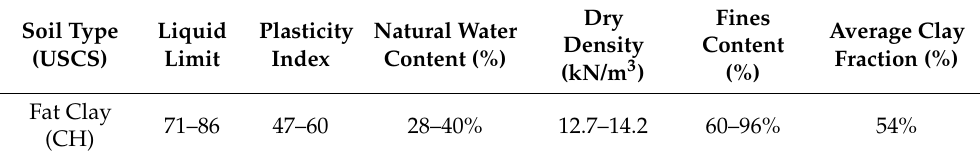
Table 1. Index Properties of the Prairie Clay at Study Location